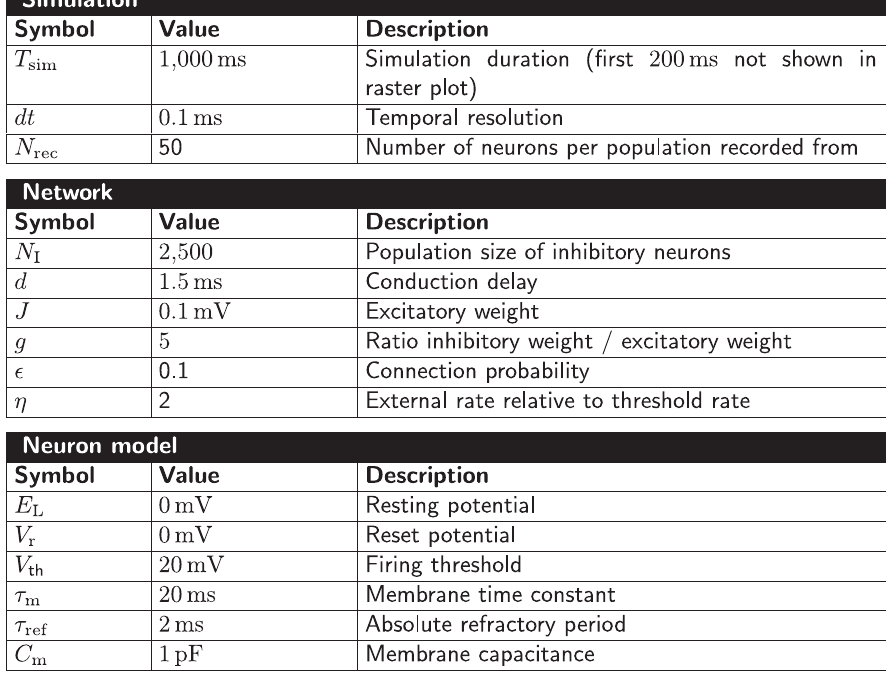
Fig 15. Simulation and network